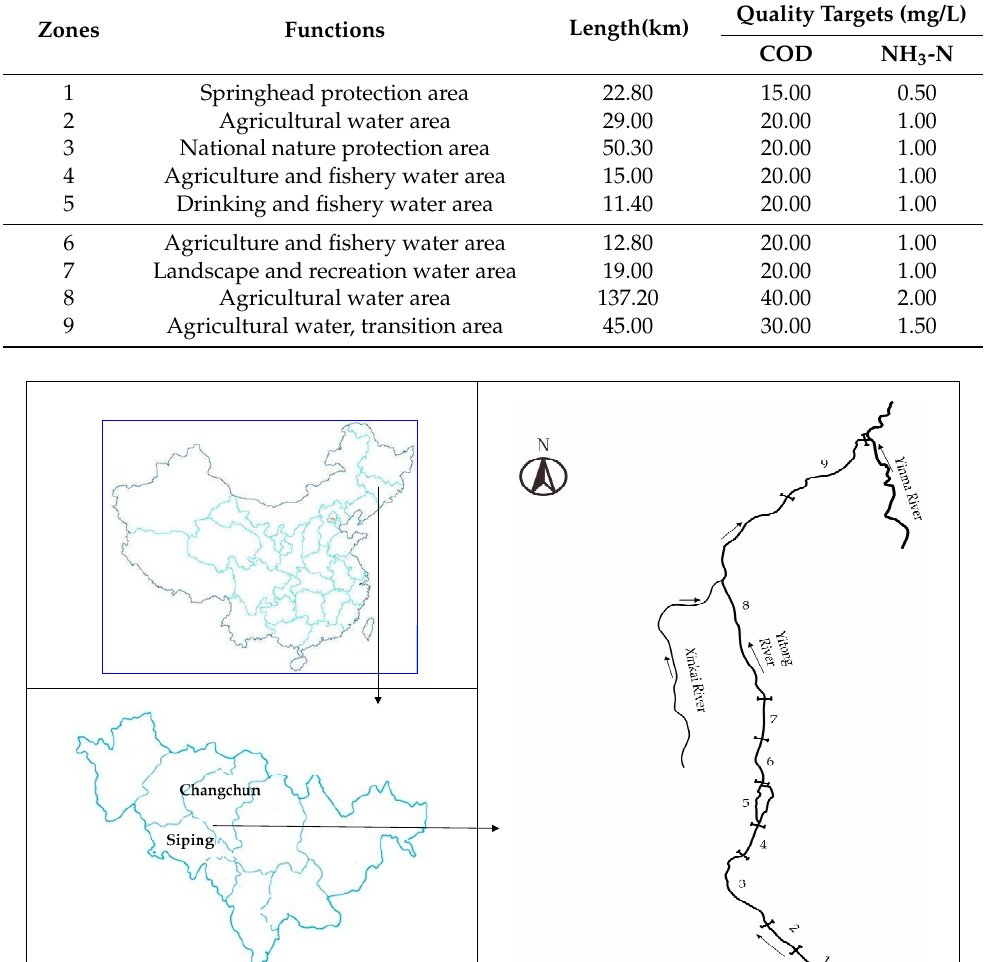
Table 1. Water functional zones in the Yitong River. (COD = chemical oxygen demand, NH 3 -N = ammonia nitrogen).